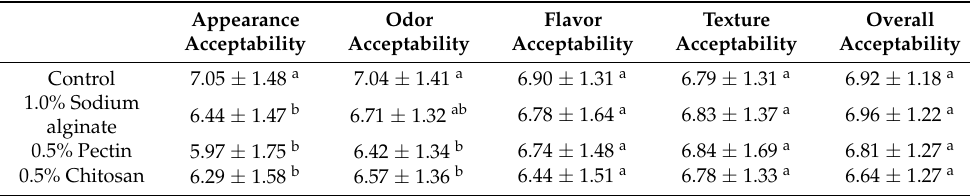
Table 3. Sensory evaluation of different hydrocolloid of